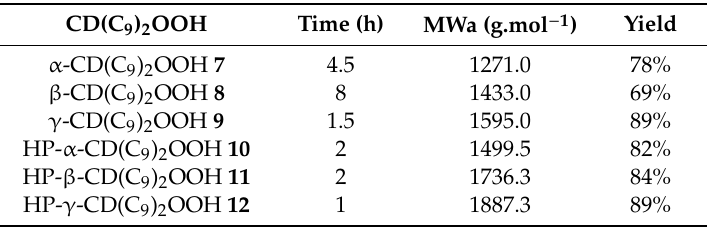
Table 2. CD(C 9 ) 2 OOH derivatives 7 – 12 obtained by enzymatic hydrolysis (the experimental conditions are depicted on Scheme 3).